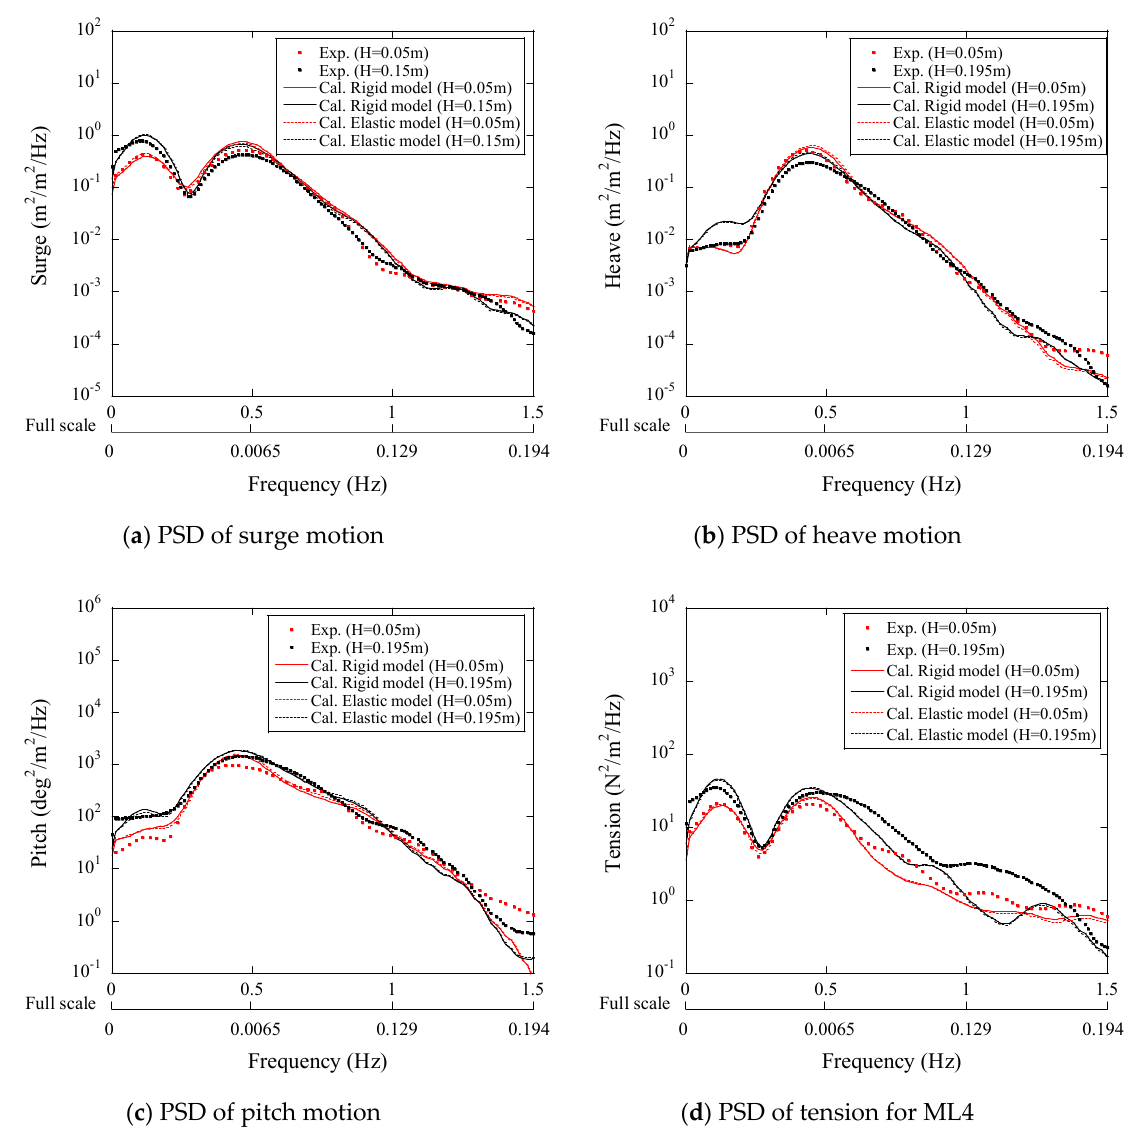
Figure 9. Normalized dynamic response of the platform in the irregular waves.